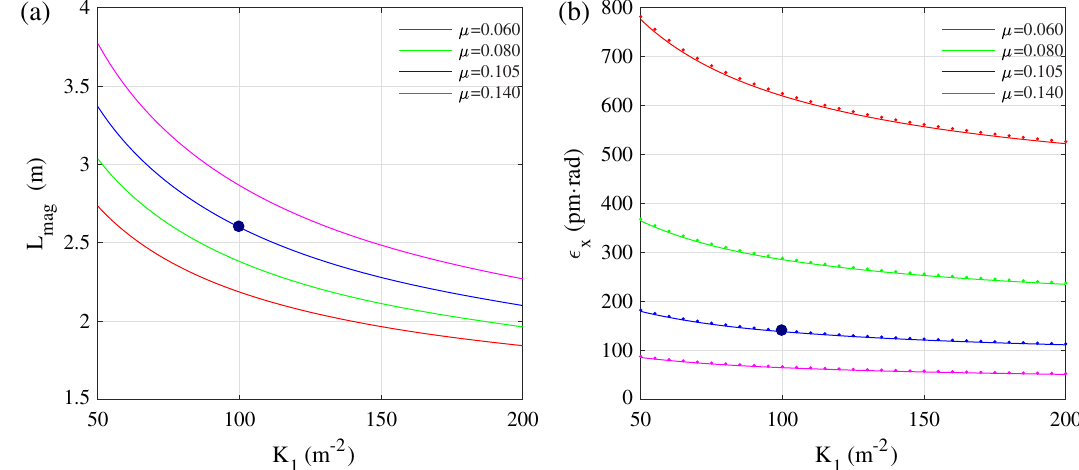
FIG. 2. Magnet length L (a) of a single magnet with ten cells and emittance ε x (b) of a ring composed of such magnets, as functions mag of the focusing gradient K 1 ¼ K 1 F ¼ − K 1 D